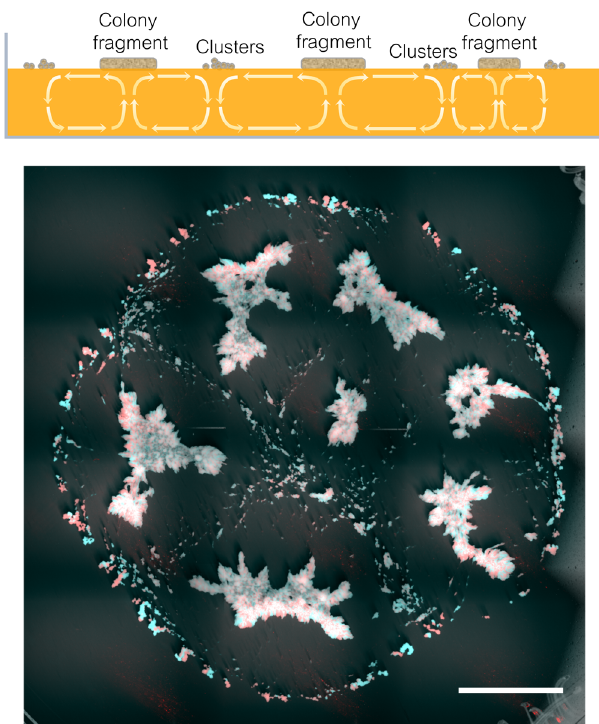
FIG. 11. Low-viscosity ( η ¼ 300 (cid:2) 45 Pa s) range expansion on a liquid substrate in the fragmentation regime. This image is taken for t ≫ t (cid:3) in a single experiment under conditions similar to those in Fig. 1(d), except that the substrate fluid height is H ¼ 4 mm instead of 7 mm. The more isolated cell fragments clearly collect on the midplanes separating the larger “ conti- nents, ” consistent with the downwellings associated with a vortex ring underneath each continent, as suggested by the sketch on the top. The scale bar corresponds to 10